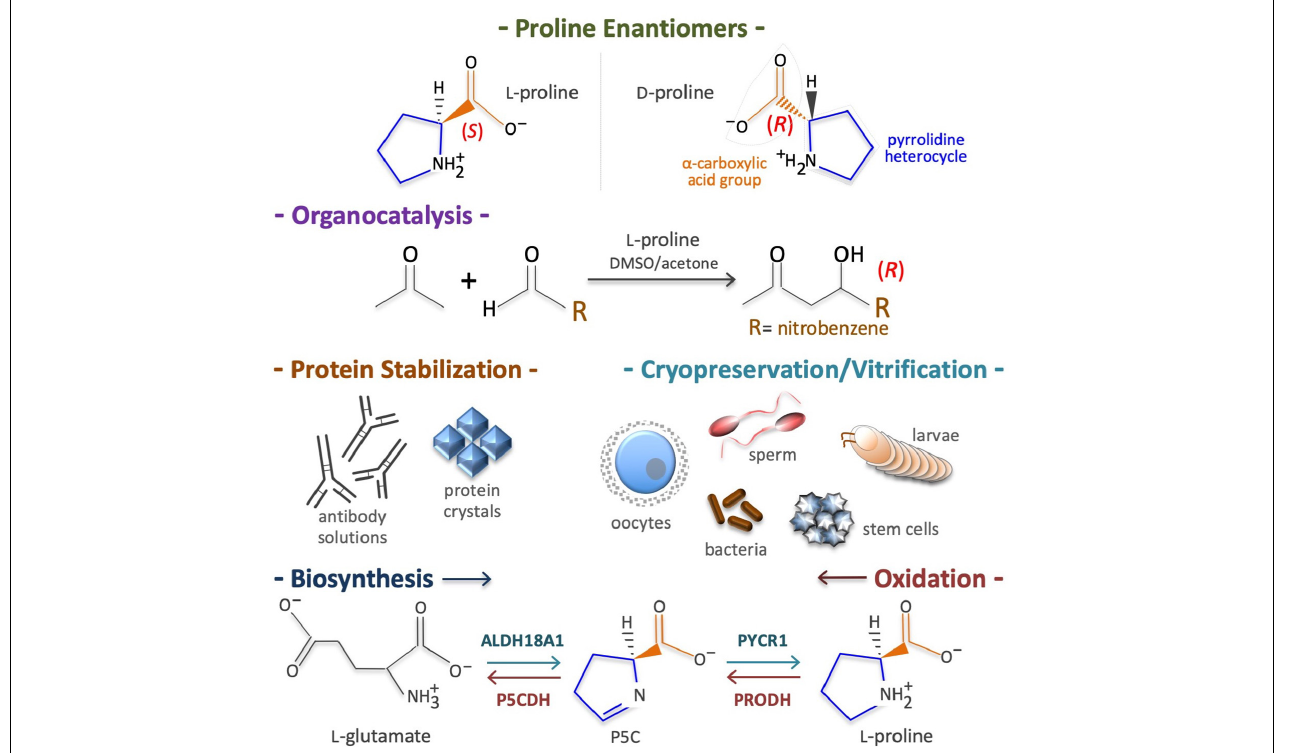
FIGURE 1 | Proline structure, uses, biosynthesis and degradation/oxidation. Chirality of pyrrolidine-2-carboxylic acid ( top ) , known as proline (CAS: 147-85-3, EC: 205-702-2, CHEBI: 17203, HMDB0000162, MW = 115.13 g/mol). Of the two enantiomers (L and D) living cells metabolize predominantly the L -proline enantiomer ( top ) . Proline is an organocatalyst used to synthesize enantiopure drugs ( middle top ) . Proline is also a potent chemical chaperone able to stabilize proteins in their natural conformation and thus, it is used to cryopreserve living cells/organisms ( middle bottom ) . Due to its pyrrolidine ring structure, the enzymes involved in de novo L -proline biosynthesis, namely aldehyde dehydrogenase 18 family member A1 (ALDH18A1) and pyrroline-5-carboxylate reductase 1 (PYCR1), as well as the enzymes involved in L -proline oxidation, namely proline dehydrogenase (PRODH) and the pyrroline-5-carboxylate dehydrogenase (P5CDH), are highly specific ( bottom )